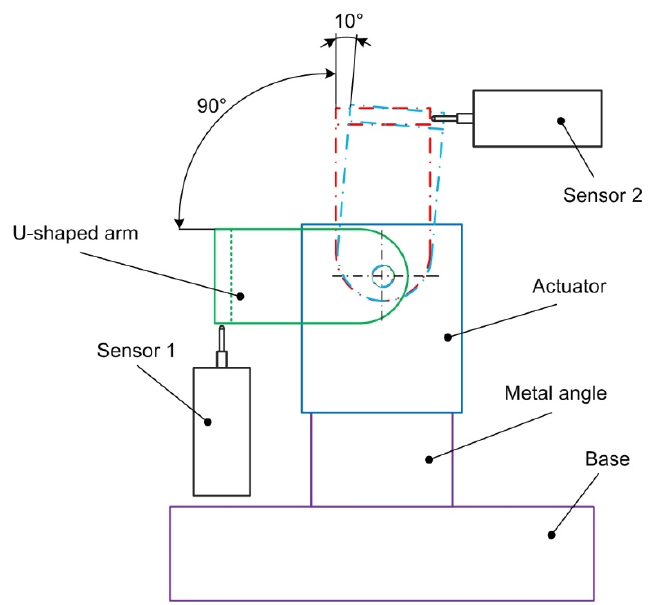
Figure 3. Placement of the actuator and the sensors.